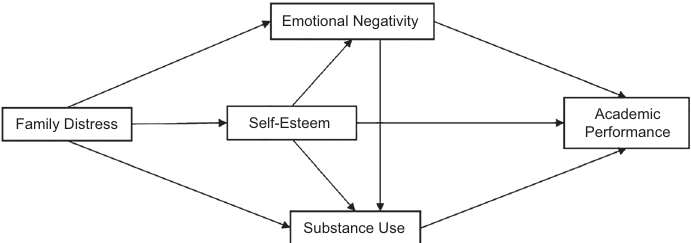
Figure 1. Conceptual model